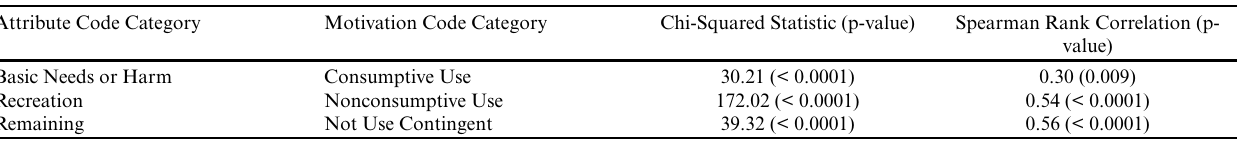
Table 5 . Summary of chi-squared and Spearman rank correlation tests for code aggregations.